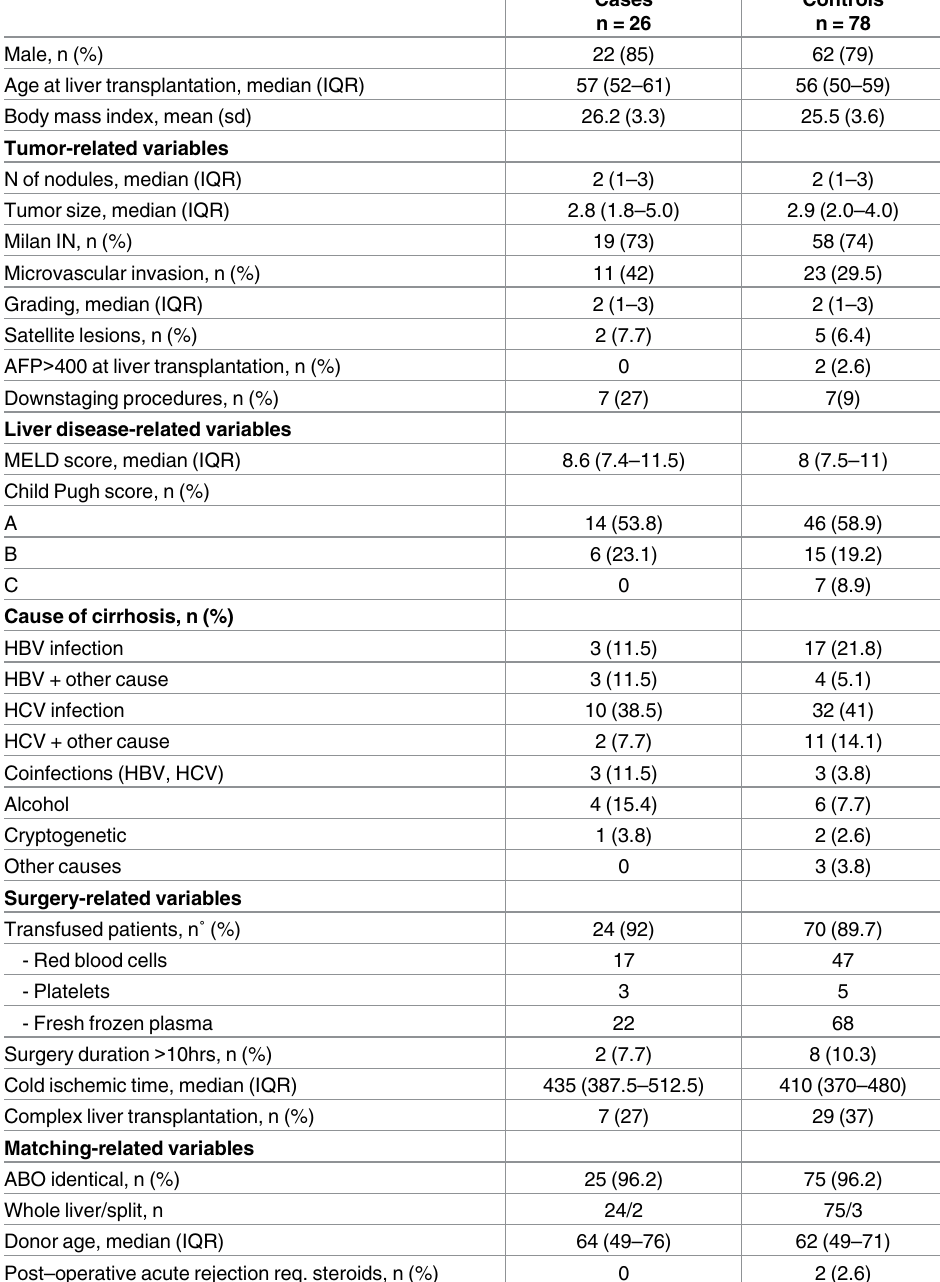
Table 3. Characteristics of patients included in the nested case-control